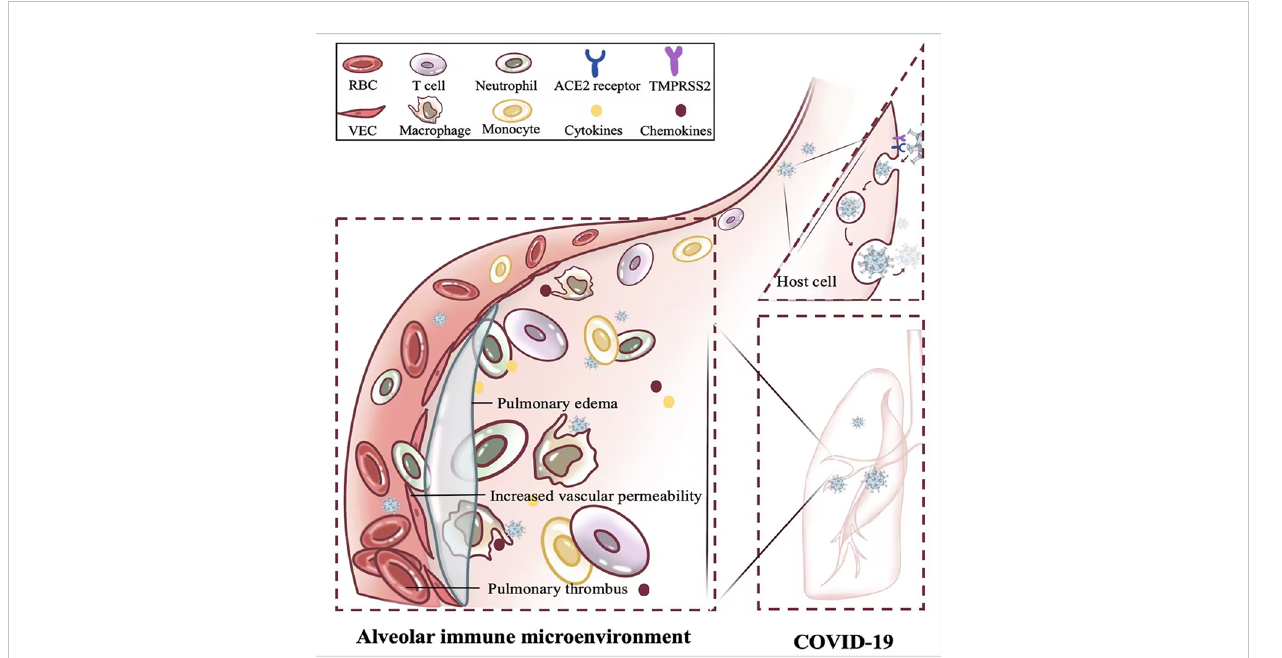
FIGURE 3 Effect of acute in fl ammation on alveolar immune microenvironment. The rapid replication of SARS-CoV-2 within the host induces acute in fl ammation in the lung, confers increased vascular permeability, heightened thrombotic risk, and triggers pulmonary edema. RBC, Red blood cell; T cell, T lymphocyte cell; ACE2, Angiotensin-converting enzyme 2; TMPRSS2, Transmembrane serine protease 2; VEC, Vascular endothelial